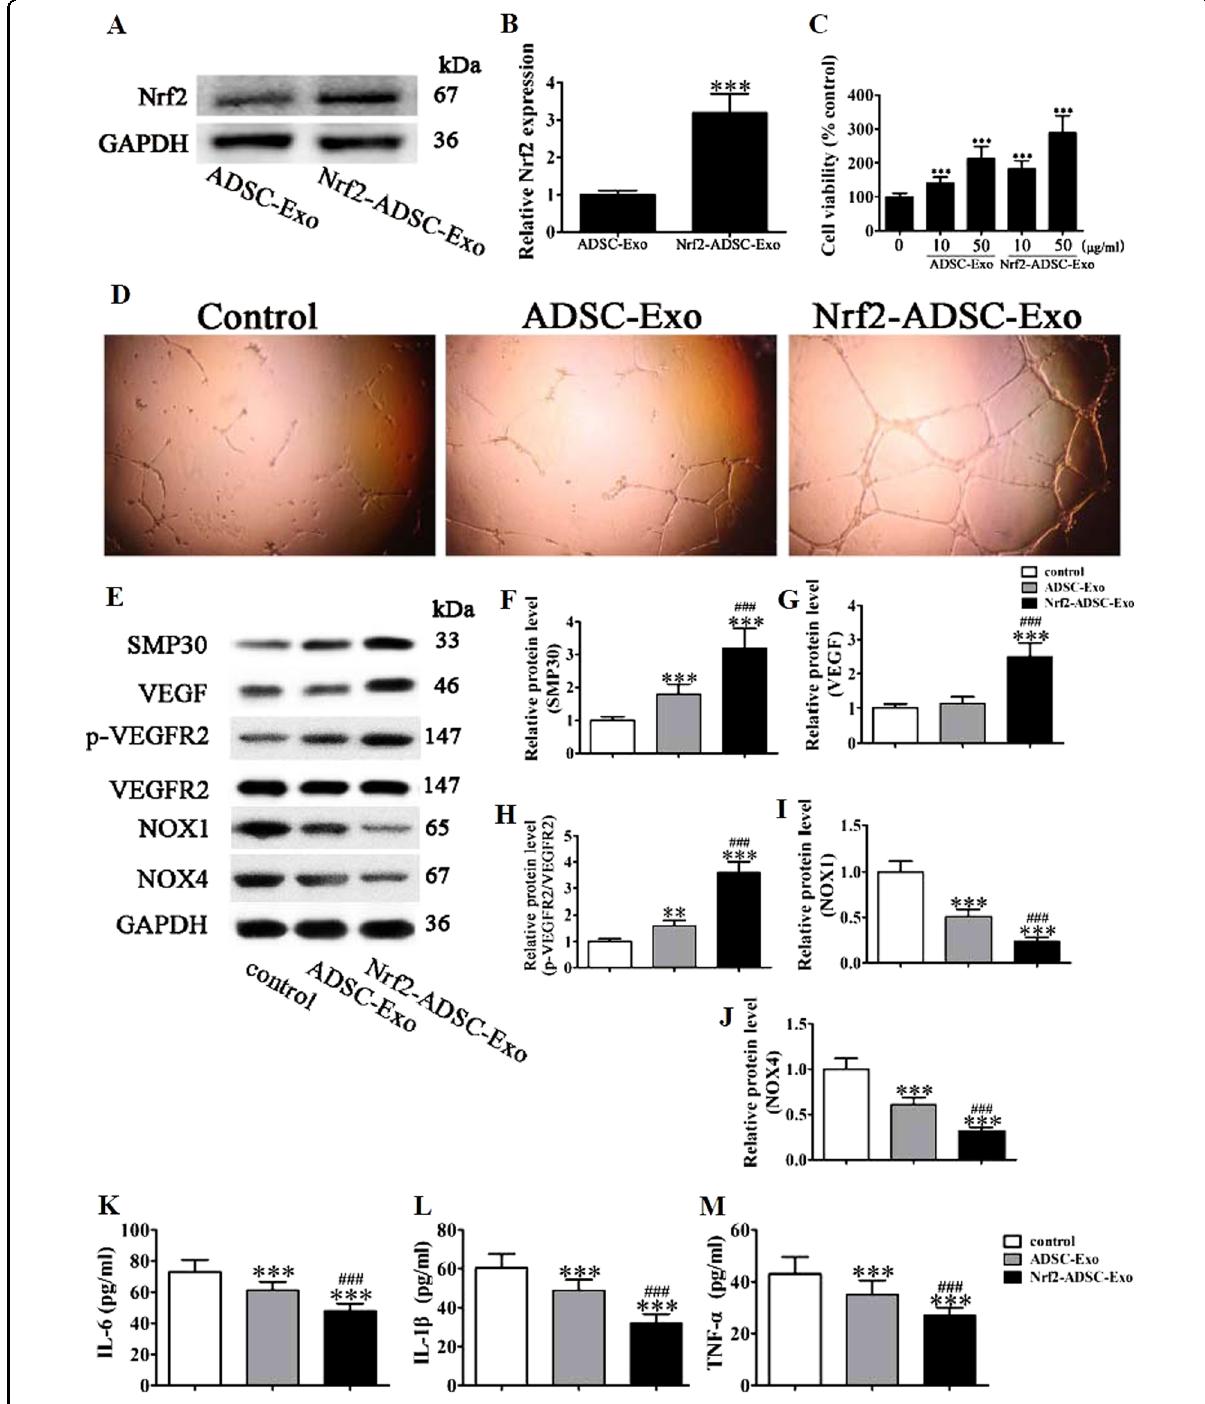
Fig. 6 Exosomes (Exos) derived from adipose-derived stem cells (ADSCs) overexpressing Nrf2 prevent high glucose (HG)-induced senescence by inhibiting ROS and in fl ammatory cytokine expression. a , b The level of Nrf2 in exosomes secreted from ADSCs with or without Nrf2 overexpression. c Proliferation of EPC cells was analyzed by the MTT assay with different concentrations of Exos from ADSCs (ADSC-Exo) or Nrf2 overexpression ADSCs (Nrf2-ADSC-Exo) after exposure to high glucose (HG, 30 mM) for 48 h. d Tube formation capability detected in endothelial progenitor cells (EPCs) stimulated with 50 μ g/ml ADSC-Exo or Nrf2-ADSC-Exo for 12 h under HG (30 mM) condition. e – j Western blot analysis and protein expression levels of SMP30, VEGF, VEGFR, and NOX1/4 after stimulation with ADSC-Exo or Nrf2-ADSC-Exo for 12 h under HG (30 mM) condition. GAPDH served as an internal control. The relative protein levels were analyzed, and data are presented as the mean ± SD ( n = 3). *** P < 0.001 vs. normal group. k – m In fl ammatory cytokine levels of IL-1 β , IL-6, and TNF- α were measured by ELISA. The relative protein levels were analyzed, and data are presented as the mean ± SD ( n = 3). * P < 0.05, ** P < 0.01, *** P < 0.001 vs. NG